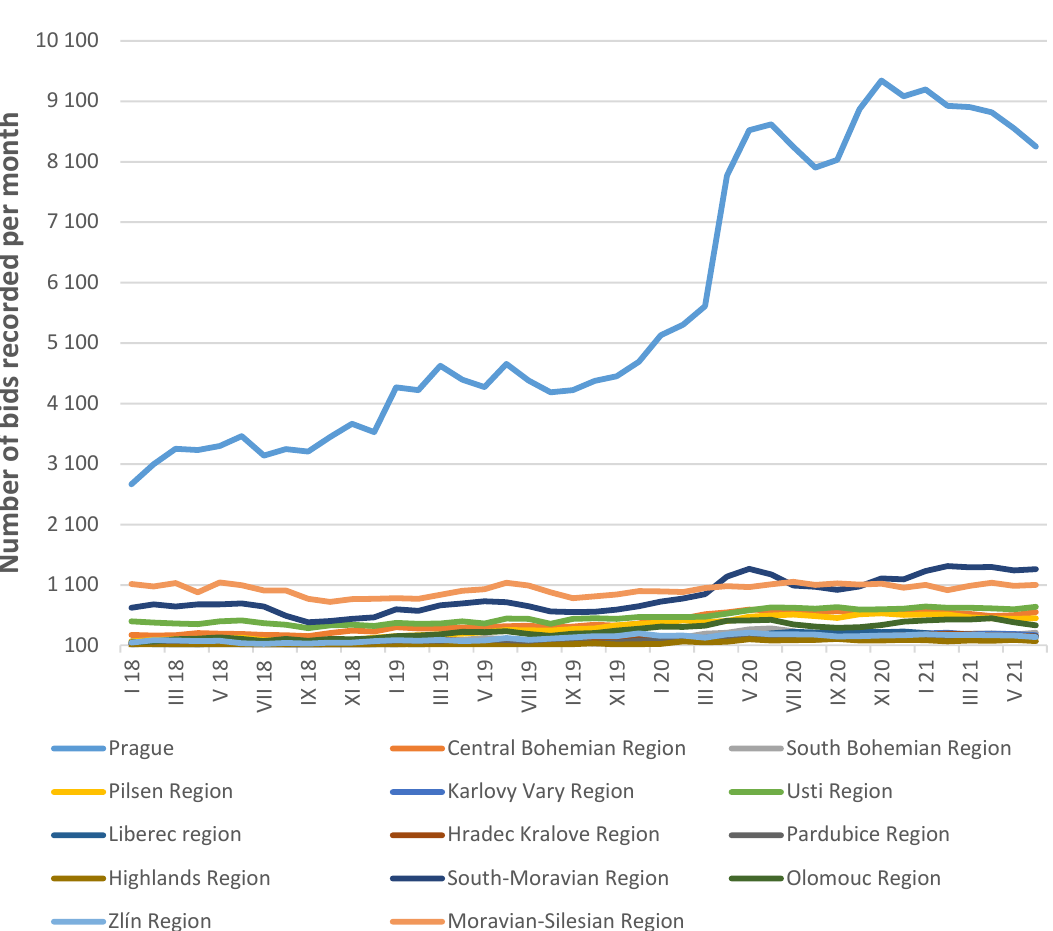
Figure 2: The number of published offers in real estate advertising per month in the category of apartments for rent, January 2018 to June 2021 Source: Software